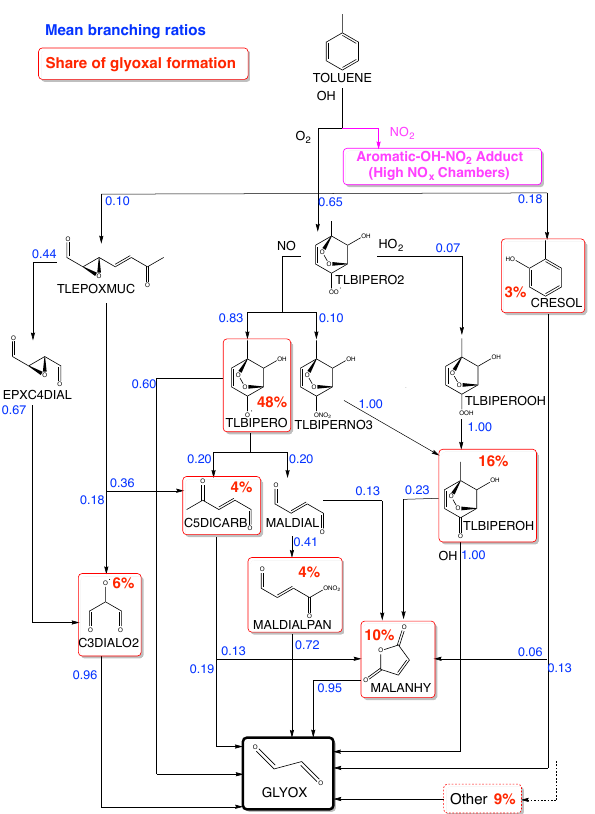
Figure 6. Pathways to glyoxal formation from toluene oxidation by OH in MCMv3.2. Only species relevant to CHOCHO formation are shown, and are labeled by their MCMv3.2 name. Branching ratios (blue) and the share of glyoxal formation from each boxed species (red) are from the 24h box model simulation described in the text. The high NO 2 pathway (not in MCMv3.2 but relevant in chamber studies) is indicated in